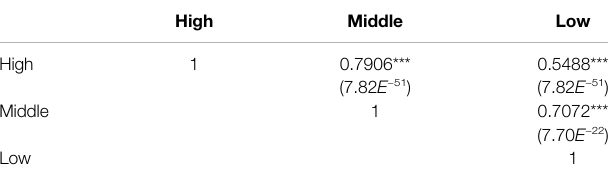
TABLE 5 | The relation of the diversi fi cation of the subsets of banks to degree centrality.